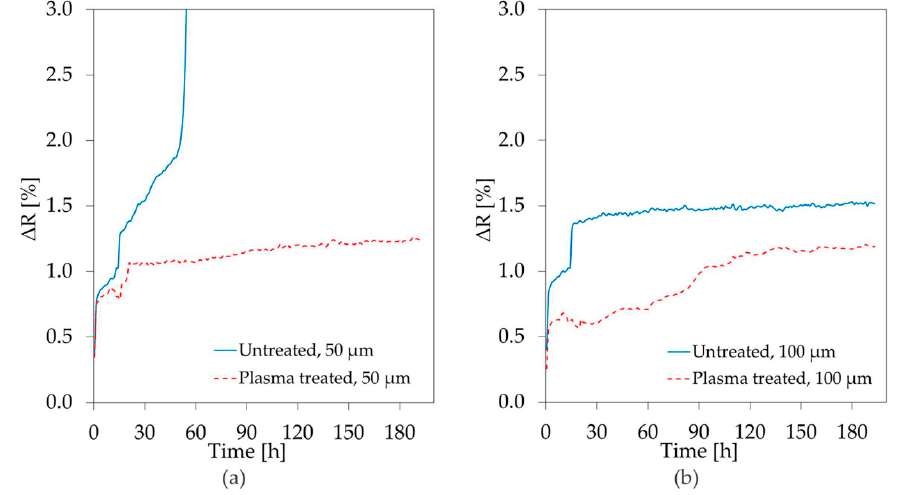
Figure 7. Percentage change, over eight days, in the resistance of ( a ) 50 µm; and ( b ) 100 µm, wide Cu track exposed to saline through a protective layer of 5 µm of Parylene-C.